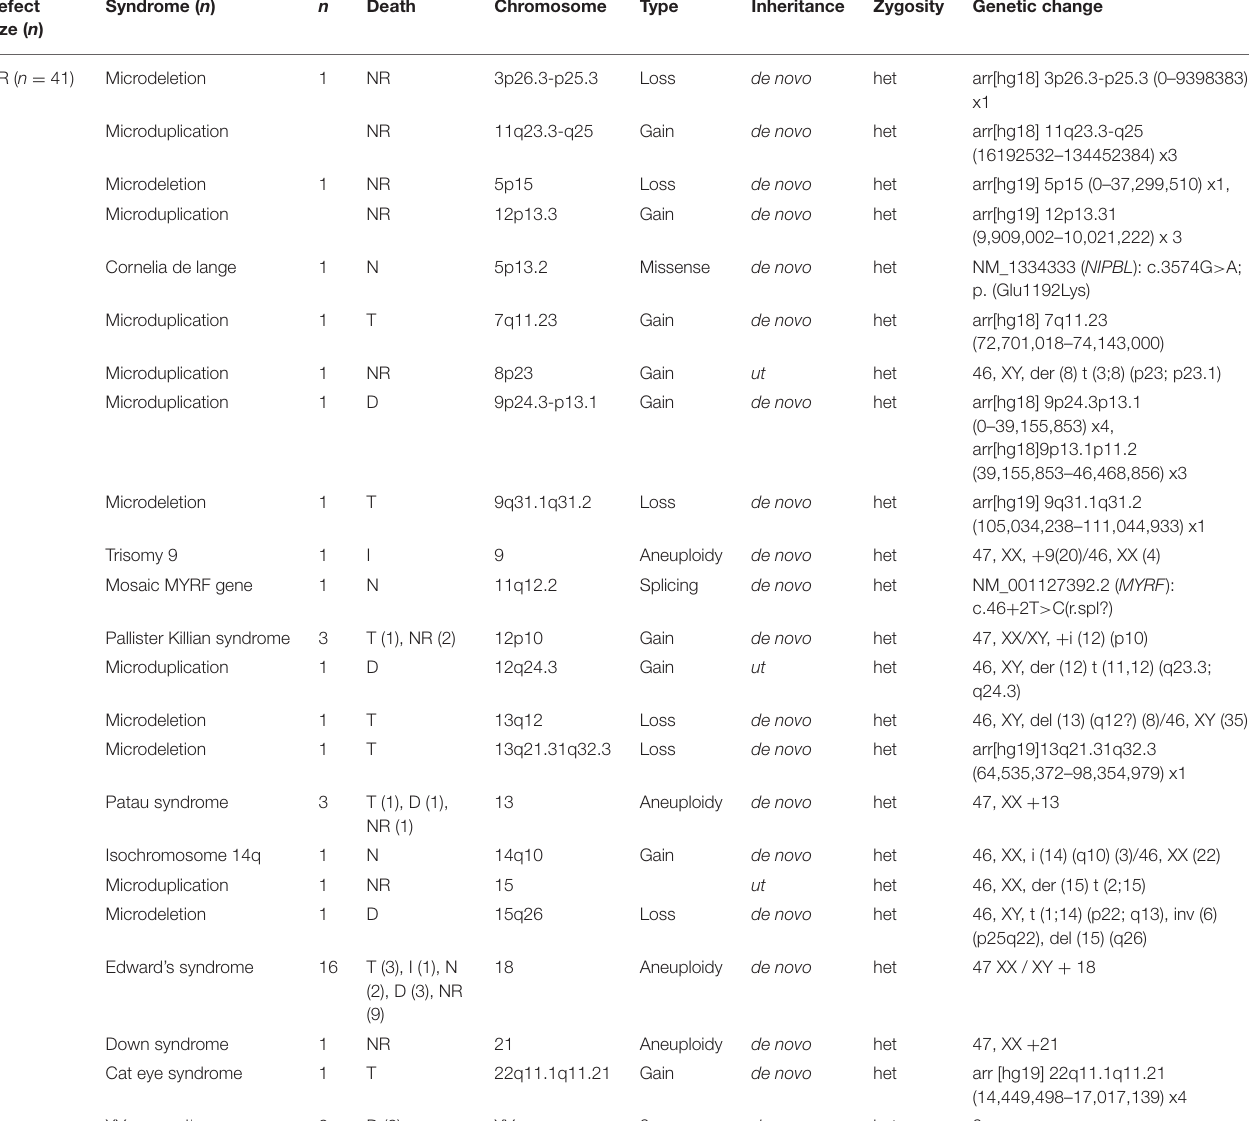
TABLE 1 | Pathogenic alterations in CDH patients of which the defect size was not registered. Defect Syndrome ( n ) n Death Chromosome Type Inheritance Zygosity Genetic size ( n )